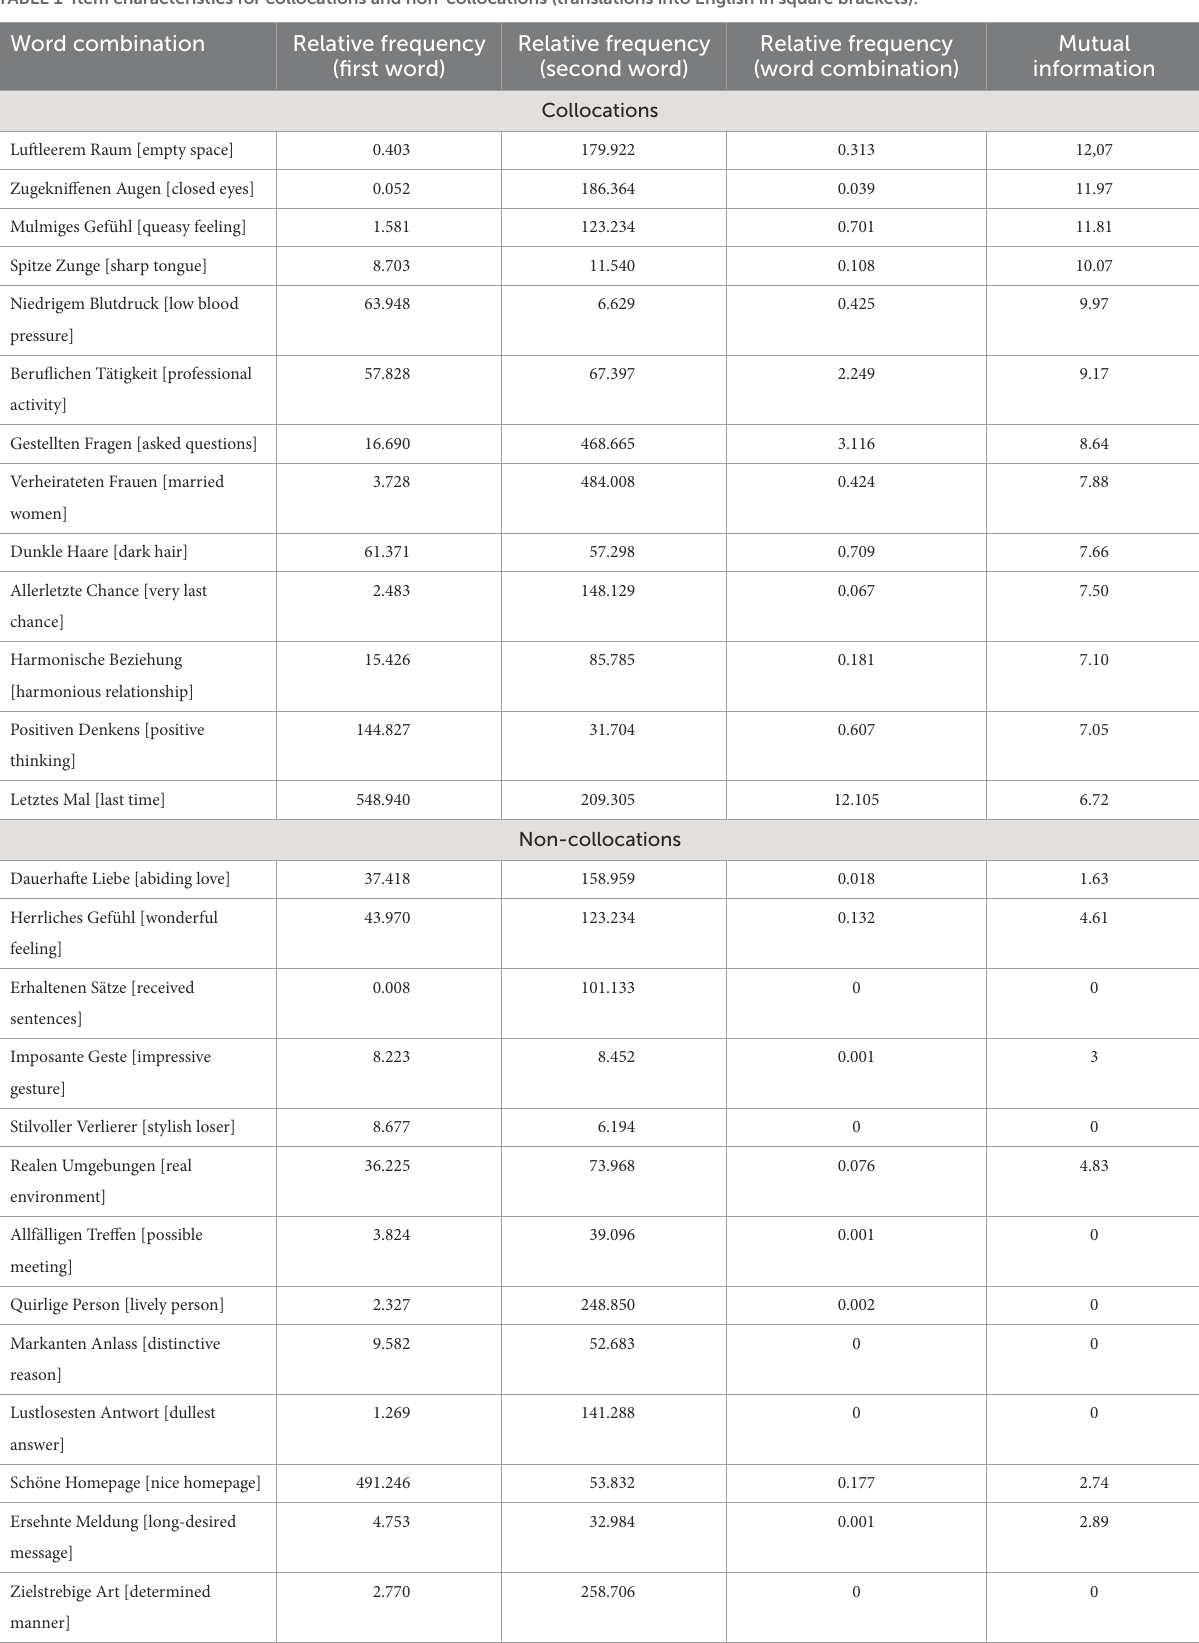
TABLE 1 Item characteristics for collocations and non-collocations (translations into English in square